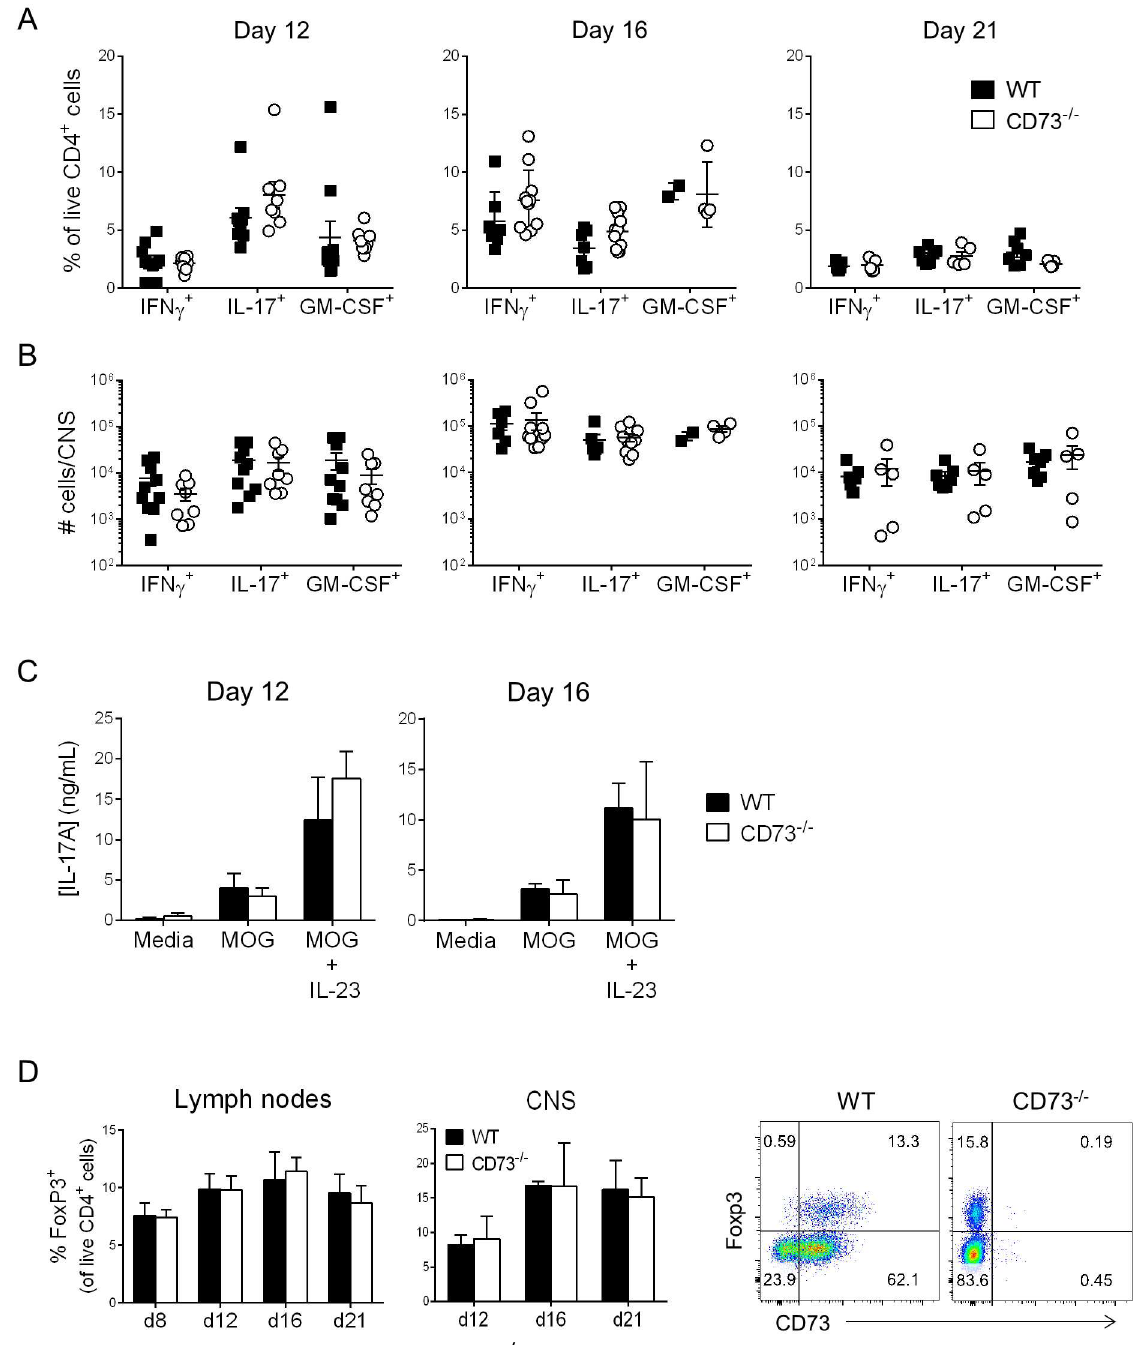
Fig 5. Th17 and Treg cells are similar in WT and CD73 -/- during EAE. Cytokineproductionand Treg frequency were analyzed by FACS in drainingLN and CNS of WT and CD73 -/- mice at day 12 (onset), day 16 (peak) and day 21 (chronic/resolution)phases of EAE. A: Frequencies of IL-17, IFN γ and GM-CSF expressingT cells, analyzedin draininglymph nodes on indicateddays after EAE induction. B: Numbers of IL-17, IFN γ and GM-CSF expressingT cells infiltratingthe CNS at indicatedtime points after immunization. A-B show mean +/- SEM of pooleddata, each point represents an individual mouse. C: Cells from draininglymph nodesat days 12 (n = 4-5/group)and 16 (n = 2-3/group)post-immunizationwere re-challenged in vitro with MOG(35–55) for three days in the presence/absenceof IL-23 (20ng/mL), and IL-17 expressionwas measuredby ELISA. D: Percentage of Tregs in the draininglymph nodesand CNS at indicatedtimepointsof EAE, FACS plots show representative staining of Foxp3 and CD73 in CNS on day 16 post-immunization, shown as mean +/- S.D. from 4–7 mice/group except day 16 WT has n = 2 mice. Data are representative of two-three independentexperiments with similar results.